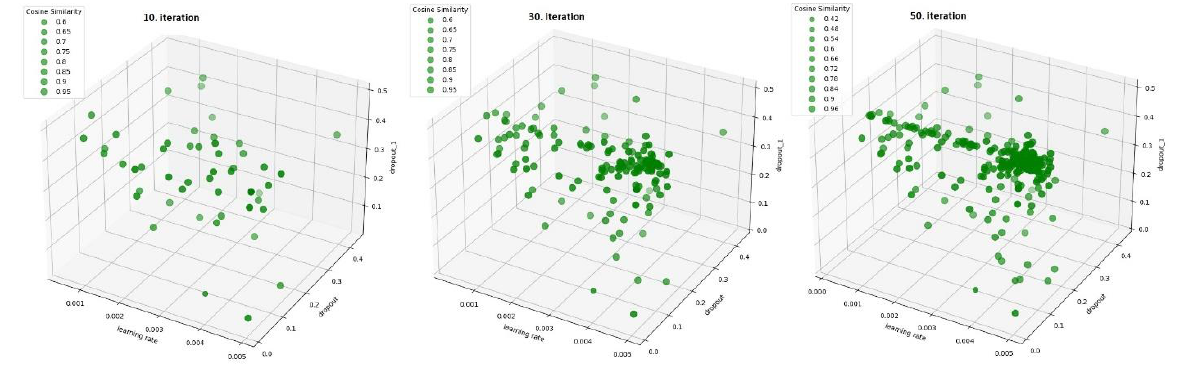
Figure 5. Particle Swarm Optimization for “dropout”, “dropout_1”, and “learning rate”.